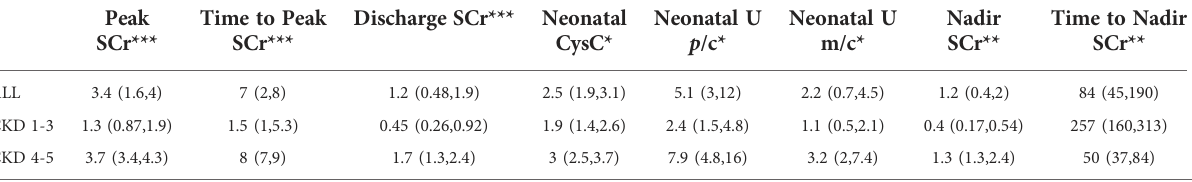
TABLE 3 Biochemical characteristics.